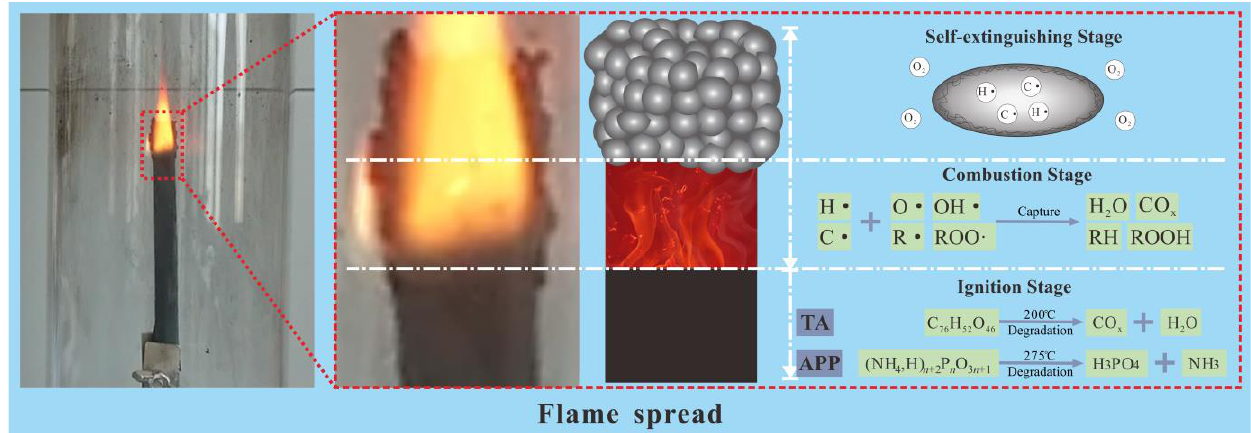
Figure 7. Flame divided into three stages: ignition, combustion, and self-extinguishing.